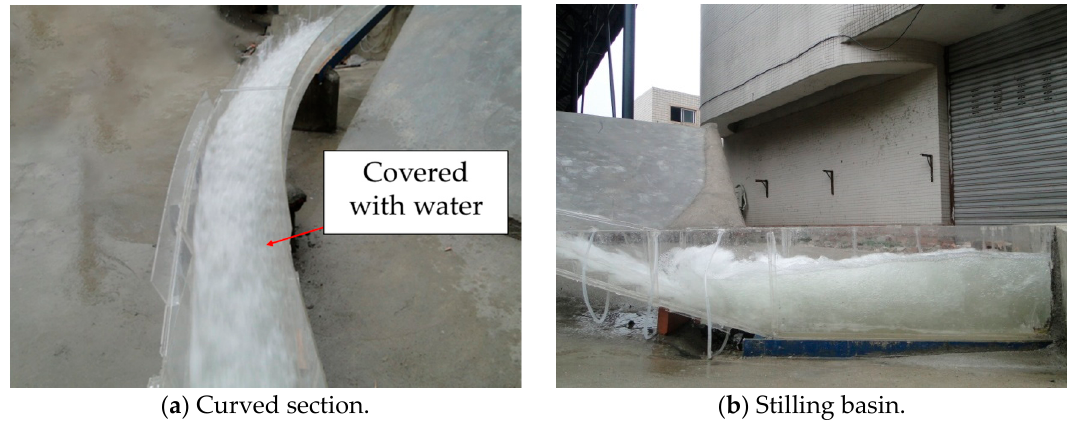
Table 2. The average water depths of each measuring point at a flow discharge rate of 272.0 m 3 /s of the